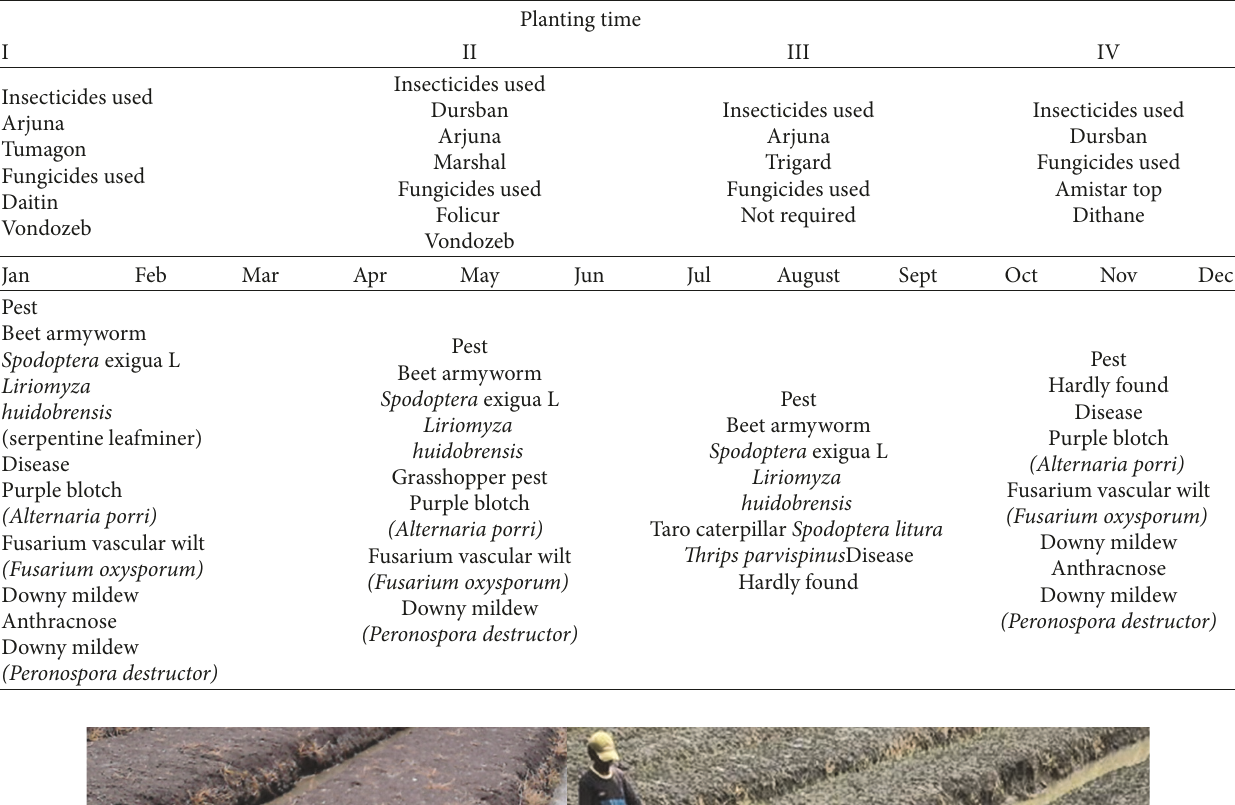
Table 1: Agriculture planting time in Wanasari Subdistrict.